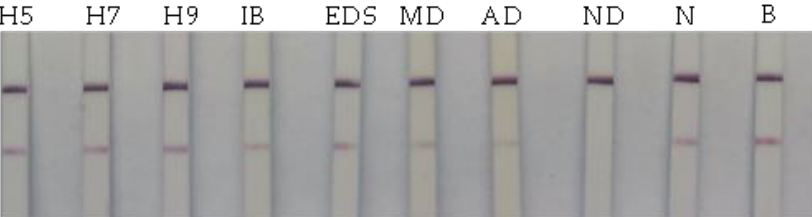
Figure 3. Determination of the bLFA strip specificity. The serum samples of the related avian viruses including AI (H5, H7, H9 subtypes), IB, EDS, MD, and AD, as well as ND positive serum and negative serum (N) were tested by the bLFA strip. Meanwhile, the HN detection antigen mixed with PBS is used as a blank control (B).